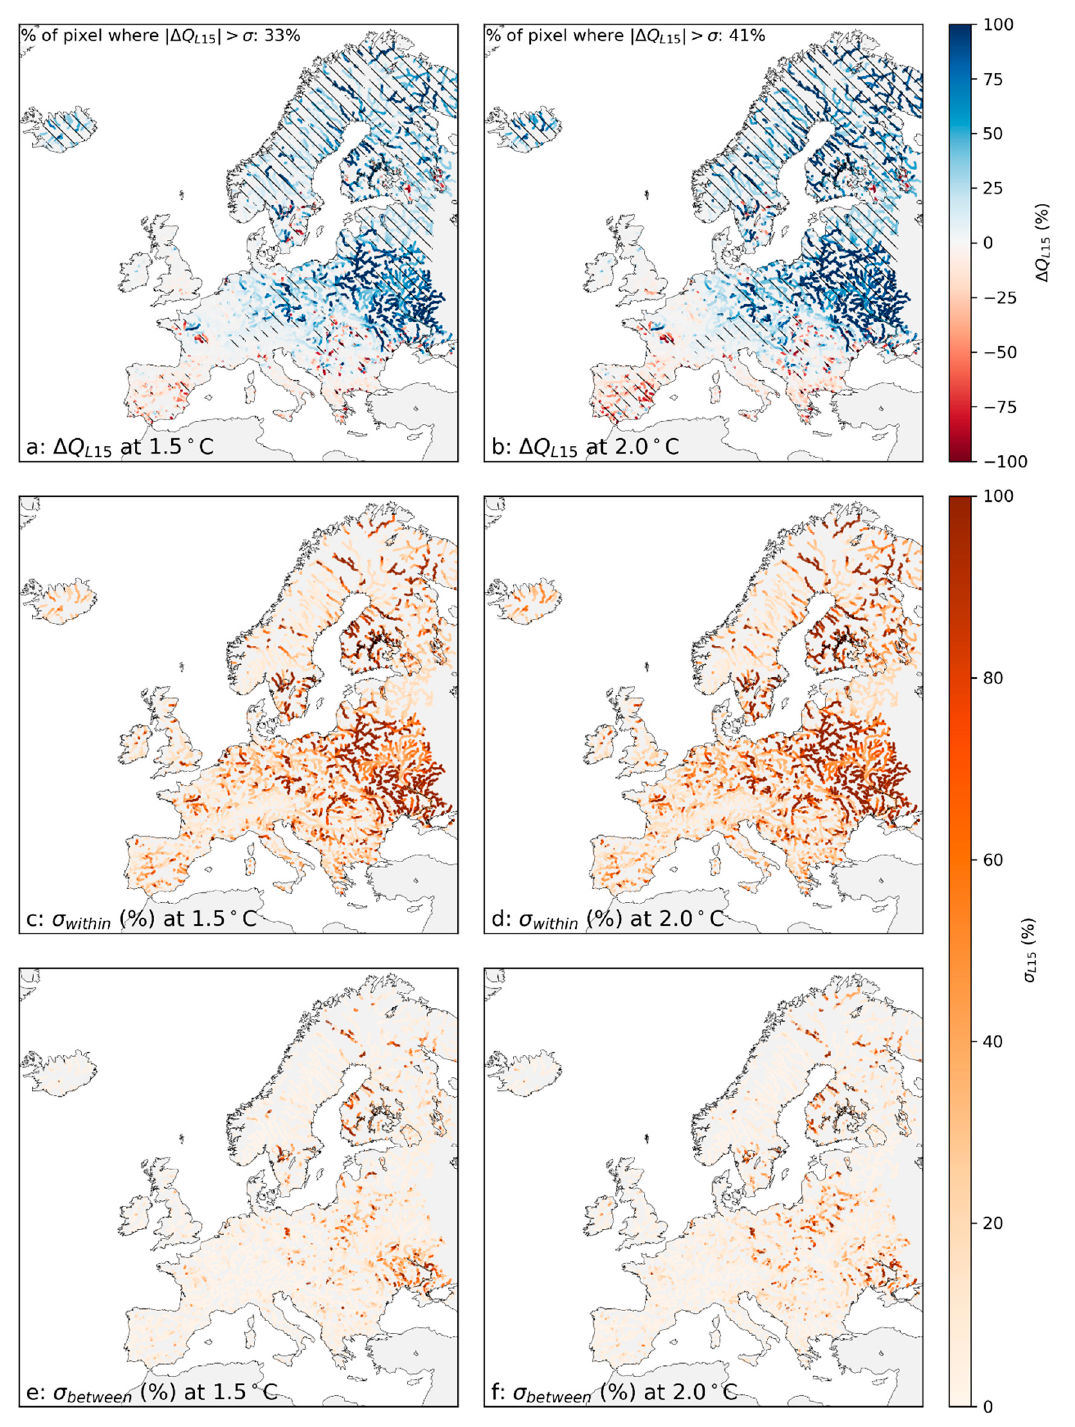
Figure 4. Same as in Figure 2 for extreme low discharge ( Q L15 ).